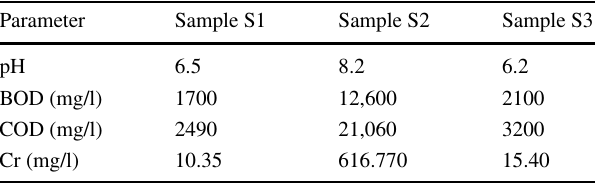
Table 5 Characteristics of tannery wastewater sample (Nur-E-Alam et al. 2018)